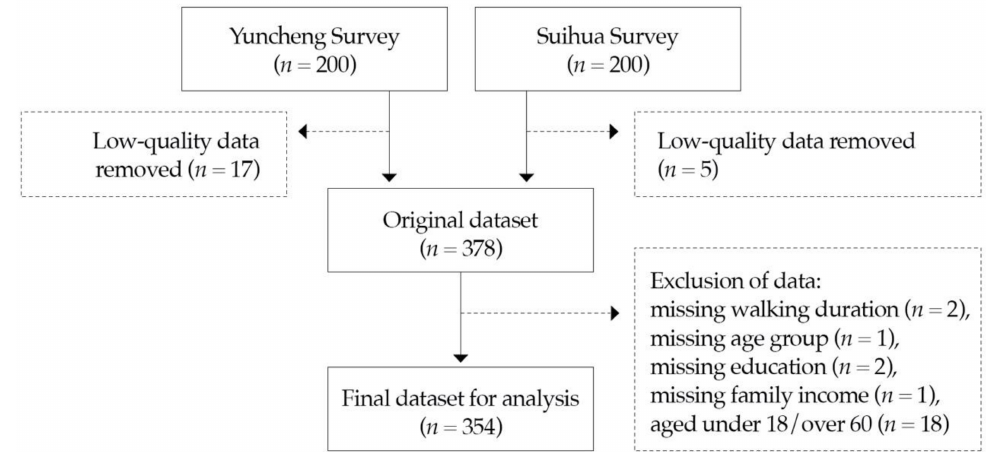
Figure 1. Flowchart of the data collection